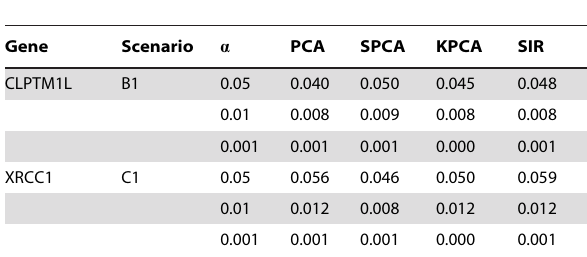
Table 7. Empirical type I error based on the real